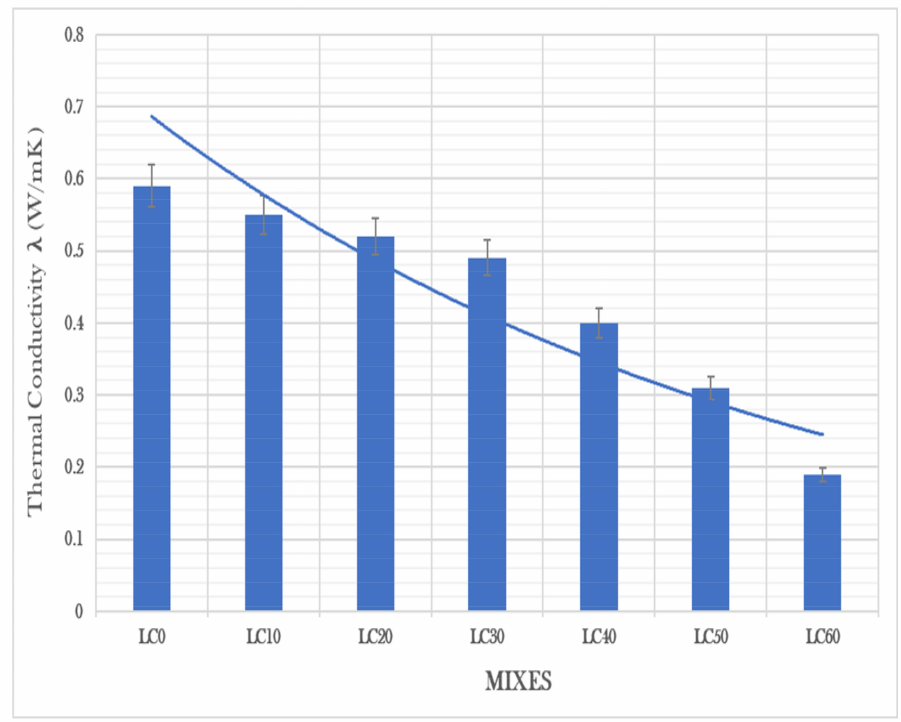
Figure 8. Effect of EPA aggregate dosage on the thermal conductivity of concrete